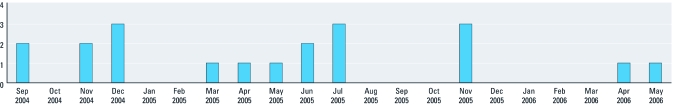
Timing of possible and probable CFP case-patients in Culebra, Puerto Rico.